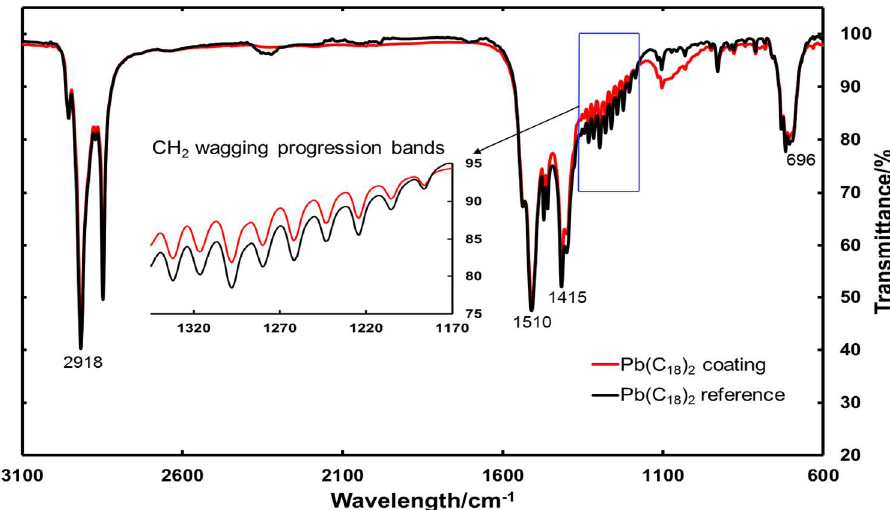
Figure 3. FTIR spectrum of the lead coupon immersed in a 50 mM NaC 18 in water/ethanol mixture (Pb(C 18 ) 2 coating) and the synthesized Pb(C 18 ) 2 reference complex.